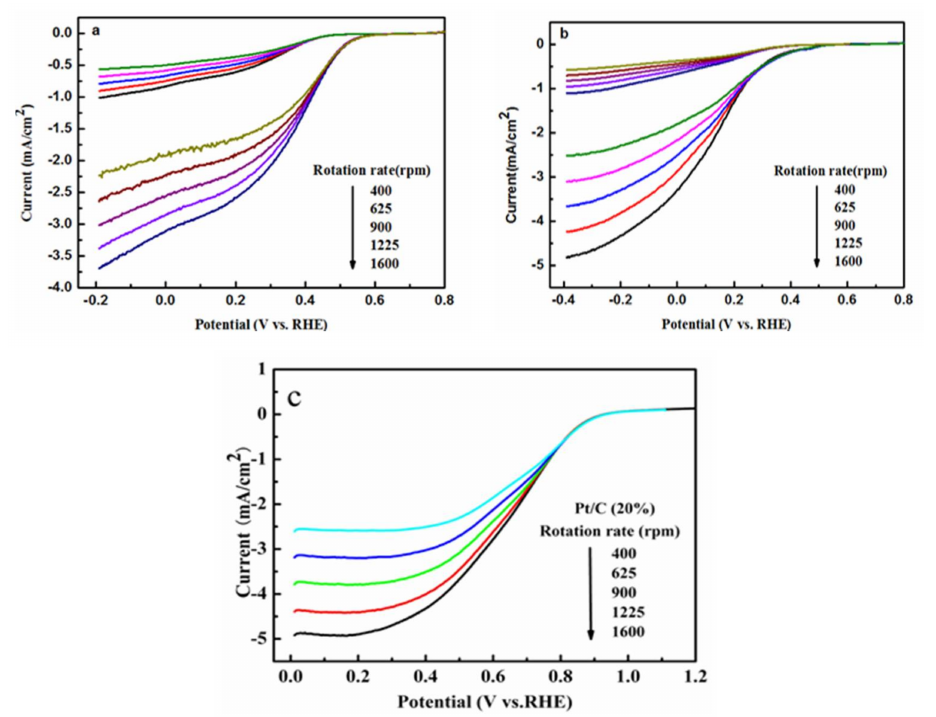
Figure 12. Polarization curves of Complex 1 /C ( a ) and Complex 2 /C ( b ) at various rotating rates in PBS solution saturated with O 2 and N 2 , and of Pt/C ( c ) at various rotating rates in PBS solution saturated with O 2 .